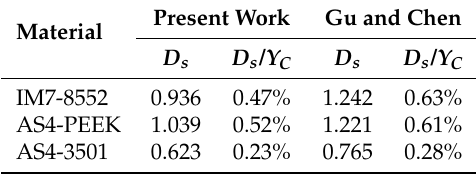
Table 10. Polyline distances (from Original Puck and Schürmann) computed for traditional composites.